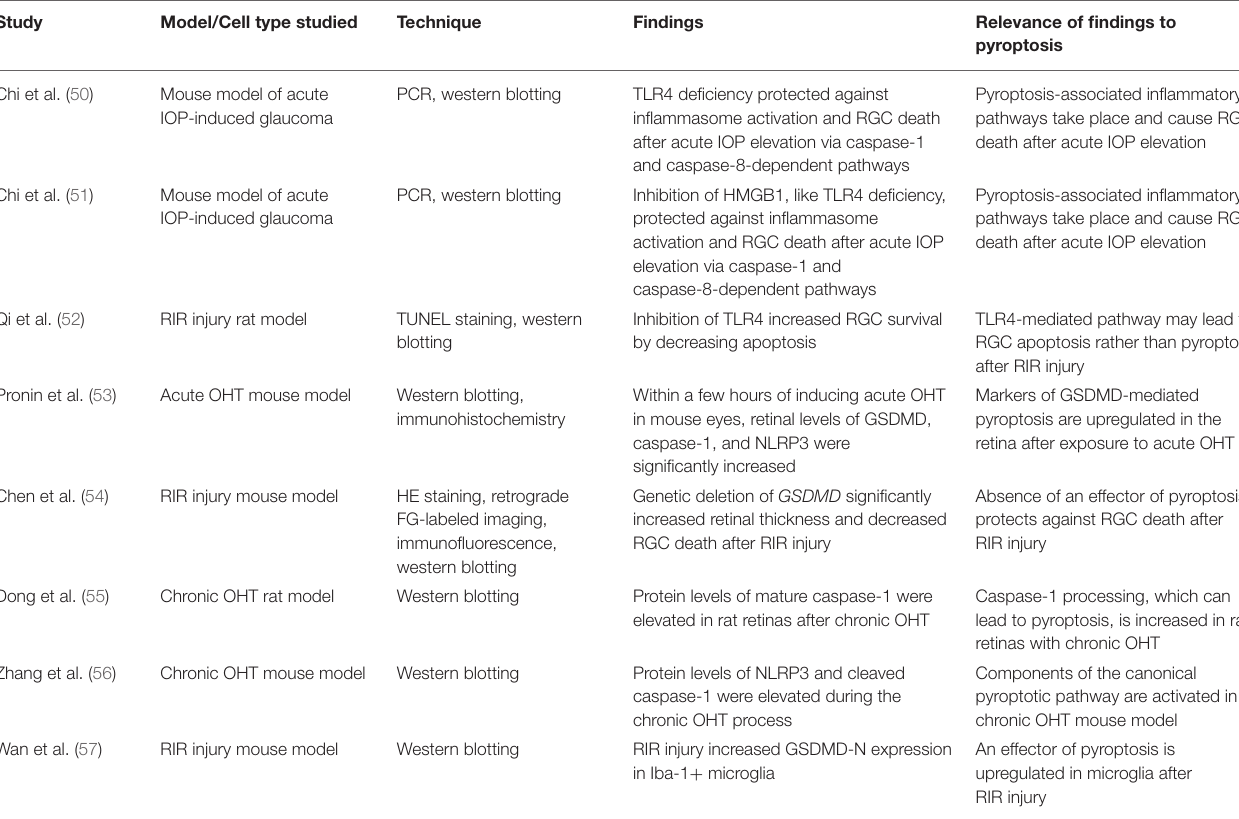
TABLE 3 | Studies investigating pyroptosis in